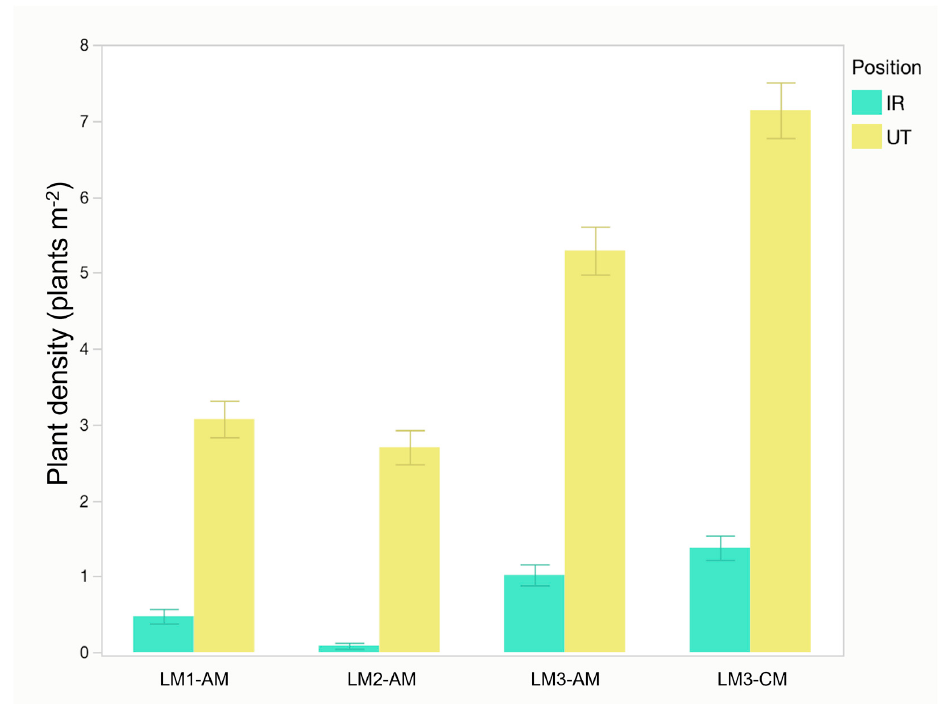
Figure 1. Erigeron canadensis plant density mean values during the two years trial in function of treatments (LM1–AM, LM2–AM, LM3–AM, LM3–CM) and positions (IR and UT). LM1–AM: living mulch 1 autonomously mowed; LM2–AM: living mulch 2 autonomously mowed; LM3–AM: living mulch 3 autonomously mowed; LM3–CM: living mulch 3 conventionally managed. IR: inter-rows, UT: Under vineyards trellis. Error bar represents the upper and lower limits of the Standard error. Trampling effect of the AM managed plot resulted higher under vineyards trellis with an average of 24 passages (ranging from 7 to 53) compared to the inter-row area with an average of 4 passages (ranging from 0 to 14). The number of passages were counted after 5 h of